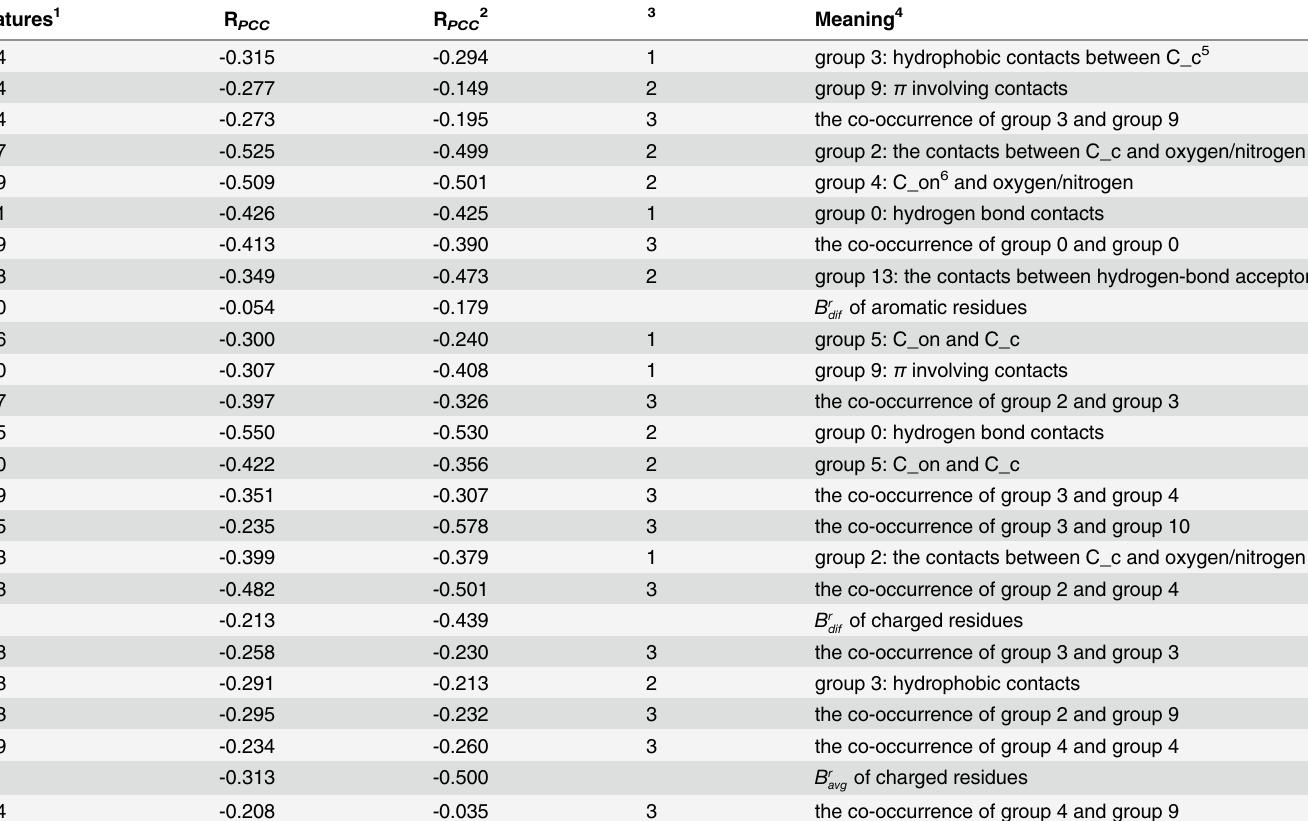
Table 5. Top 25 important features from Fig 2. R PCC represents the Pearson correlation coefficient. As many features have tens or hundreds of zero values (refer to Figs 3, 4 and 5 for example), R PCC itself is not able to produce a useful ranking here. Features